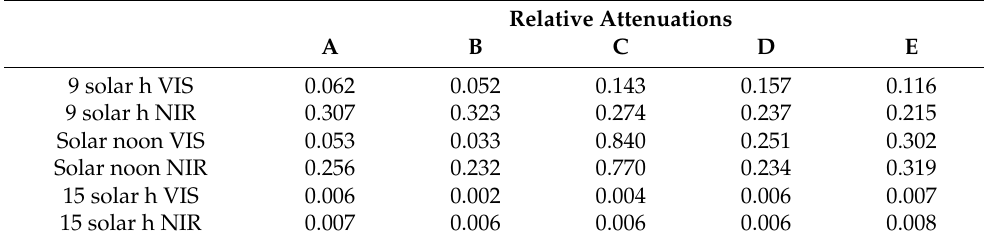
Table 6. Values of the average relative attenuations for the VIS and NIR bands in winter at 3 times of day.